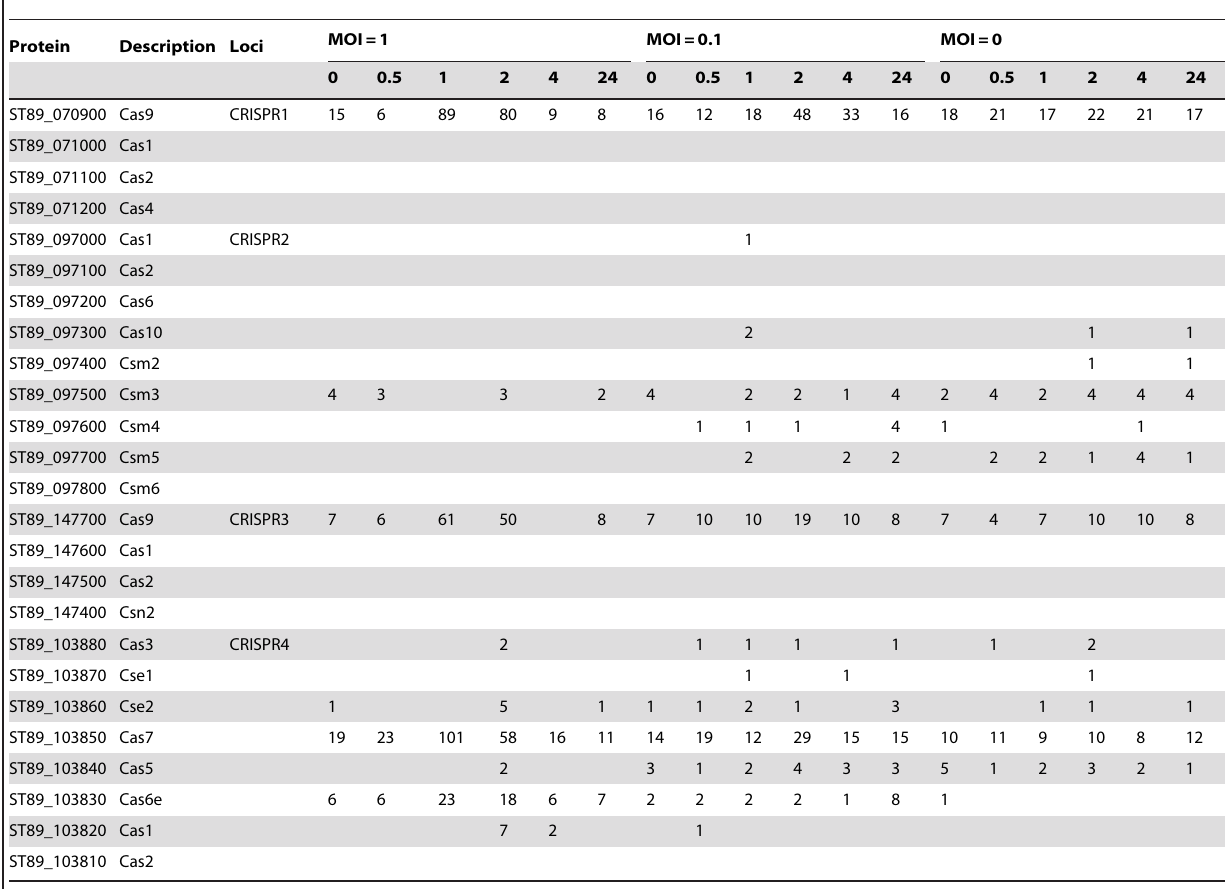
Table 3. Expression of Cas proteins from S. thermophilus DGCC710 across time.